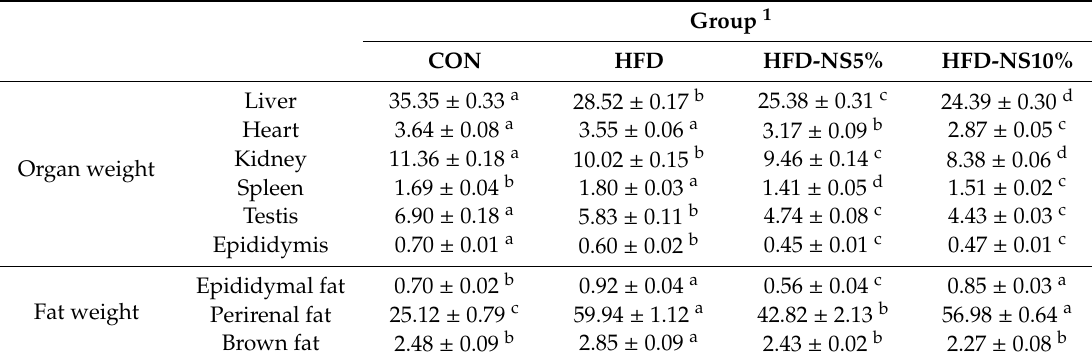
Table 3. E ff ect of Nelumbinis Semen powder on unit organ weight ( n = 8 /